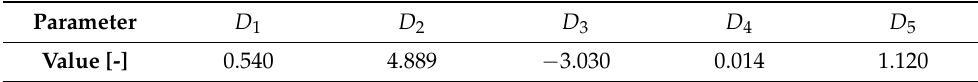
Table 8. Johnson–Cook failure model parameters for OFHC copper.